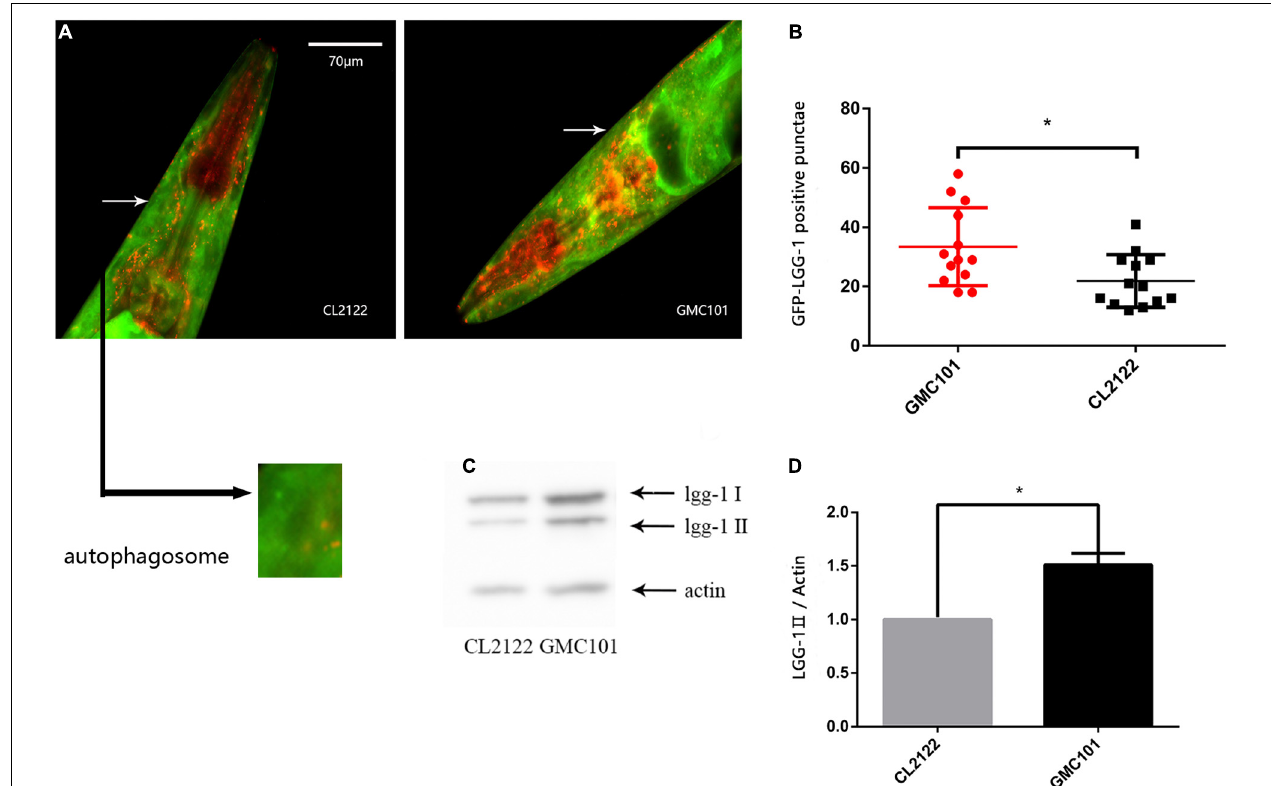
FIGURE 1 | Autophagosome accumulation in GMC101 and CL2122 strains. (A) Punctae formation as shown by fluorescence microscopy. (B) Scoring of punctae showing a significant increase in the GMC101 strain ( n = 15 for CL2122 and n = 18 for GMC101, * p < 0.05 by the Student’s t -test). (C) Representative western blot of mCherry::GFP::lgg-1 in CL2122 and GMC101 strains. (D) Quantified western blot gel intensities, as determined by ImageJ software ( n = 3, * p < 0.05 by the Student’s t